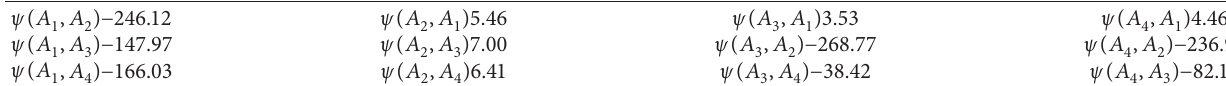
Table 5: Prospect dominance degrees.